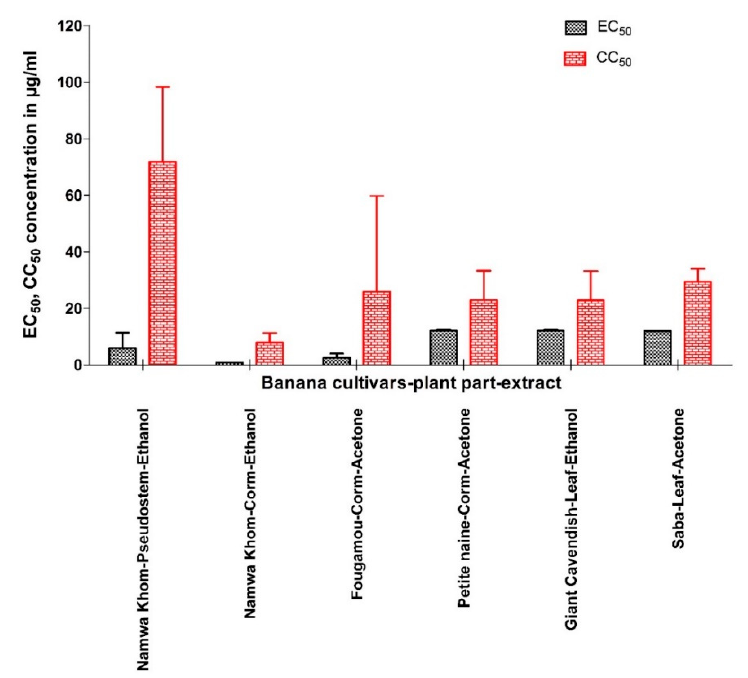
Figure 6. Construction of UPGMA dendrogram using all tested cultivars. Figure 4. Comparison of EC 50 and CC 50 (mean ± SD) of selected banana cultivars’ plant part extract against yellow fever virus.